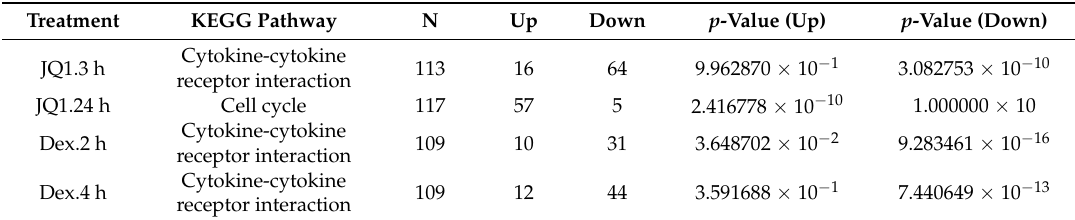
Table 4. Most significantly enriched Kyoto Encyclopedia of Genes & Genomes (KEGG) pathways for different